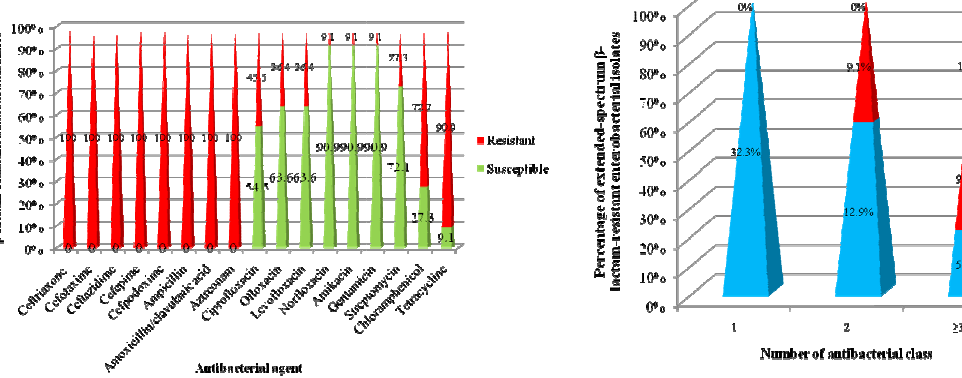
Fig. 5. Resistance of extended-